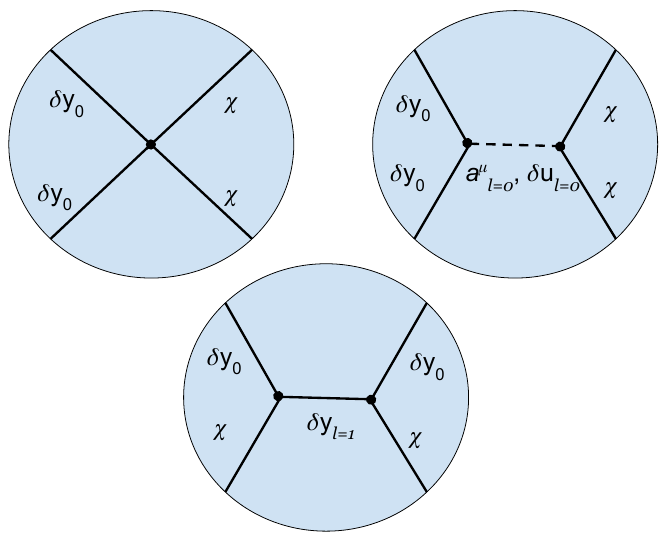
Figure 18. Witten diagrams for computing the connected part of the four-point function h χ i χ i δy a 1 δy a 2 i . The l = 0 modes of δu and a µ fields as well as the l = 1 modes of δy a field 0 0 1 2 are exchanged in the exchange